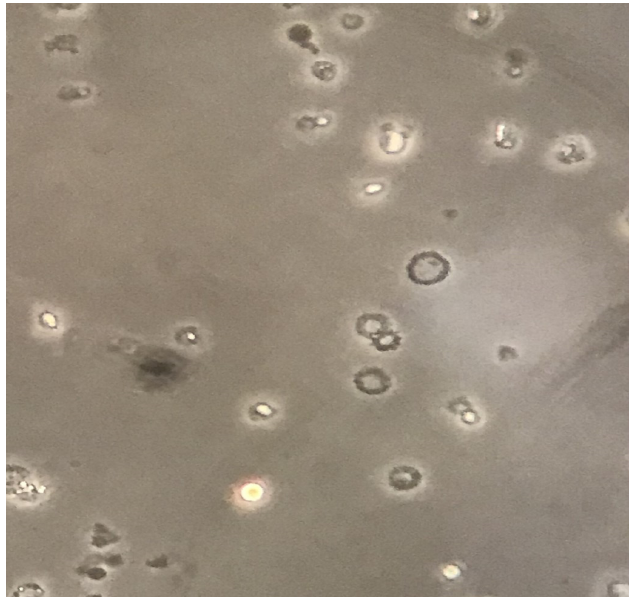
Figure 1. Urinary sediment, magnification 400×. Dysmorphic erythrocytes, most of which are acanthocytes, an indication of their glomerular origin.